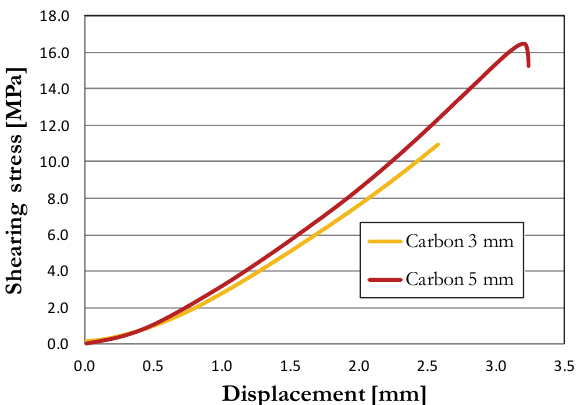
Figure 6: Influence of the carbon adherend